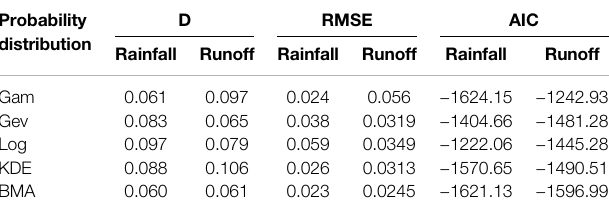
TABLE 2 | The D, RMSE and AIC analysis for marginal